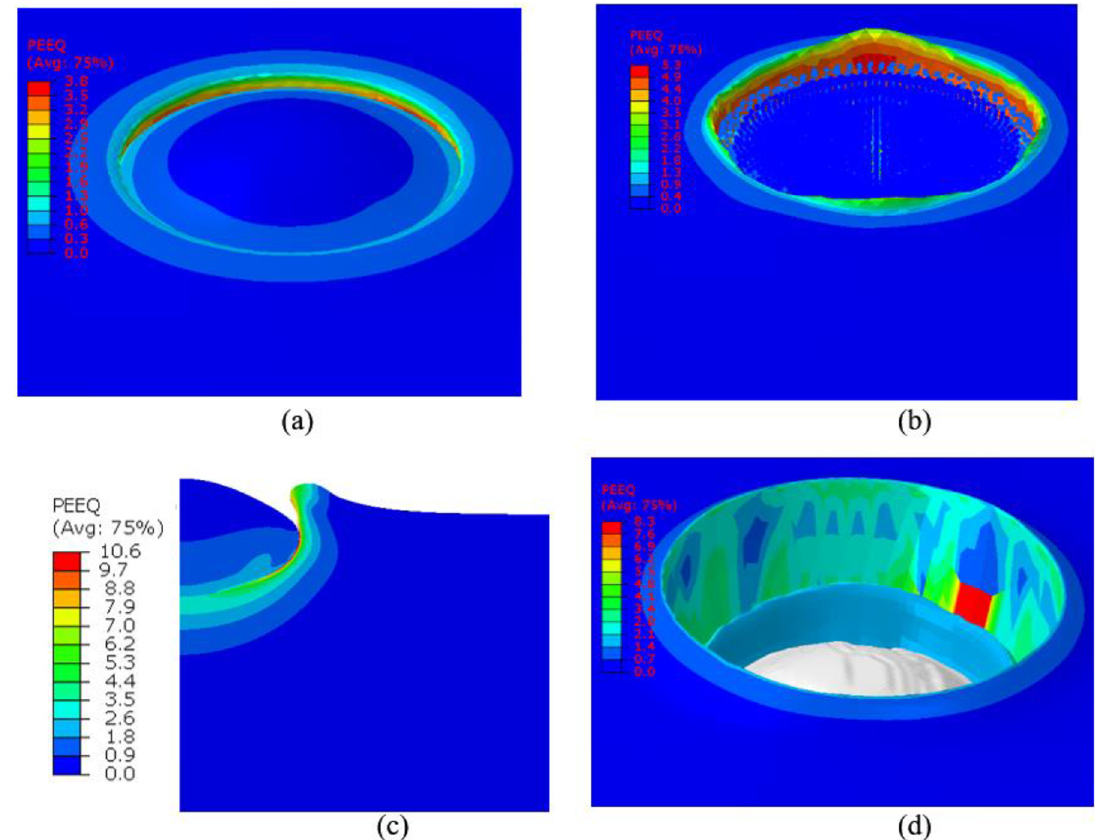
Fig. 13. Effective plastic strain evolution of (a) Lagrangian model (b) SPH model (c) ALE model (d) CEL model of a Cu/Al single particle impact at 500m/s.